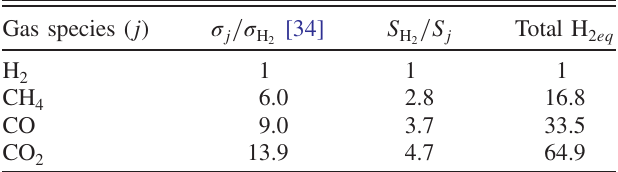
TABLE II. Equivalences to H 2 of the different gas